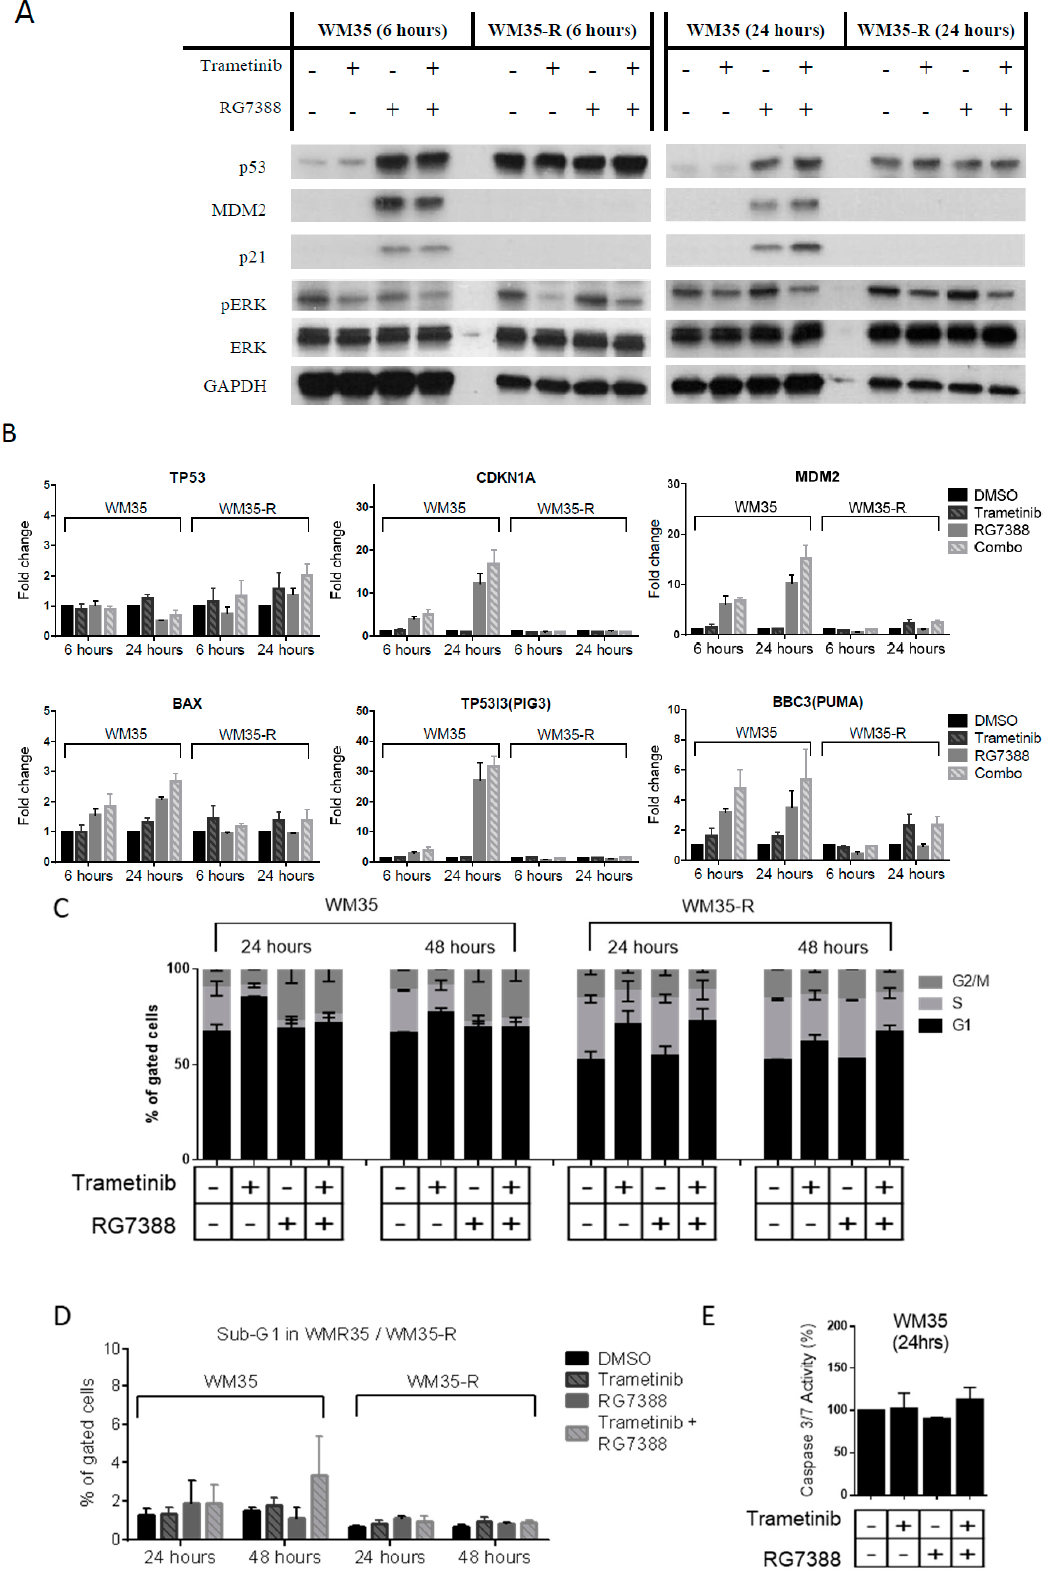
Figure 3. Trametinib and MDM2 inhibitor combination treatments in paired WM35 (p53 WT )/WM35-R (p53 MUT ). Cells treated with RG7388 (0.2 µM) ± trametinib (1 nM) for indicated times and analyzed by immunoblotting ( A ) and qRT-PCR ( B ), by FACS analysis for cell cycle distribution changes ( C ) and sub-G1 events ( D ), and for caspase 3/7 activity ( E ). hrs, hours.